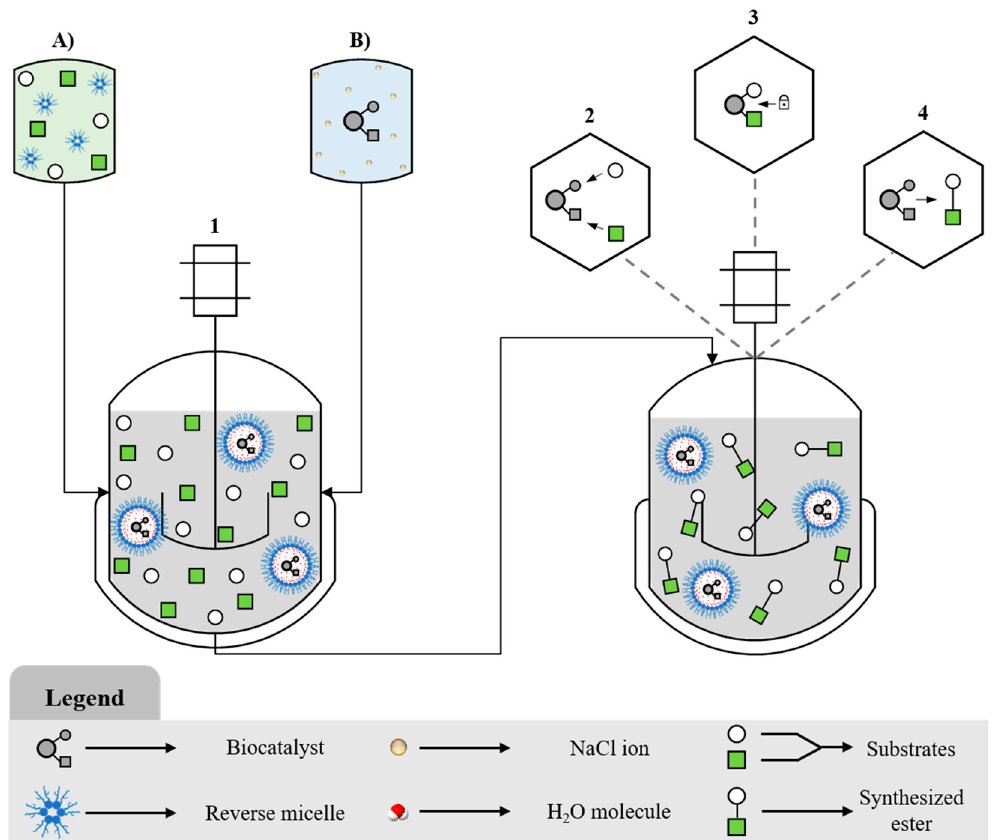
Figure 5. General scheme to solubilize lipases in reverse micelles through the injection method for ester synthesis reactions. (A) Reservoir of organic solvent with substrates and solubilized reverse micelles in the medium, (B) Enzyme reservoir with buffer at optimum pH and required NaCl concentration. (1) Mixing of reaction components for intimate and partial contact between liquid–liquid phases, (2) Specific attraction of the substrates to the enzyme active site, (3) Catalysis of the synthesis reaction where an ester is produced, (4) Transfer of the ester out of the enzyme active site. Authors’ elaboration and adapted from Novozymes Biopharma [98].